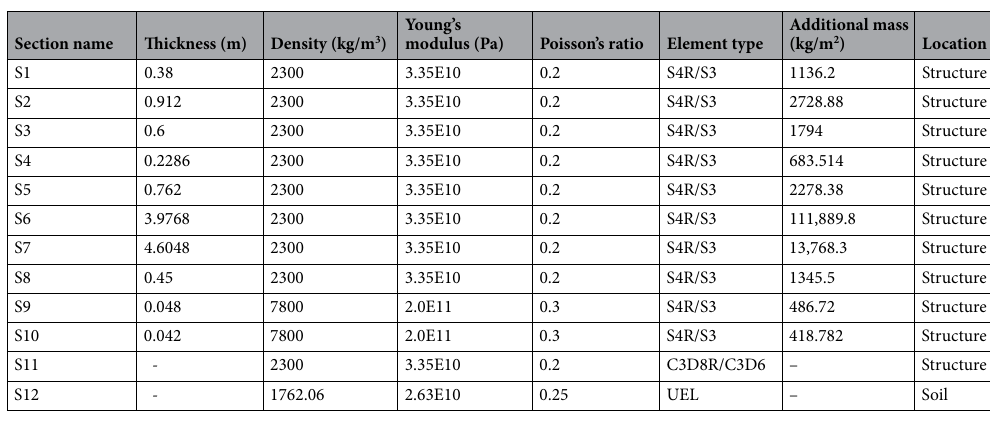
Table 5. Section properties of the SSI model of the nuclear power plant.